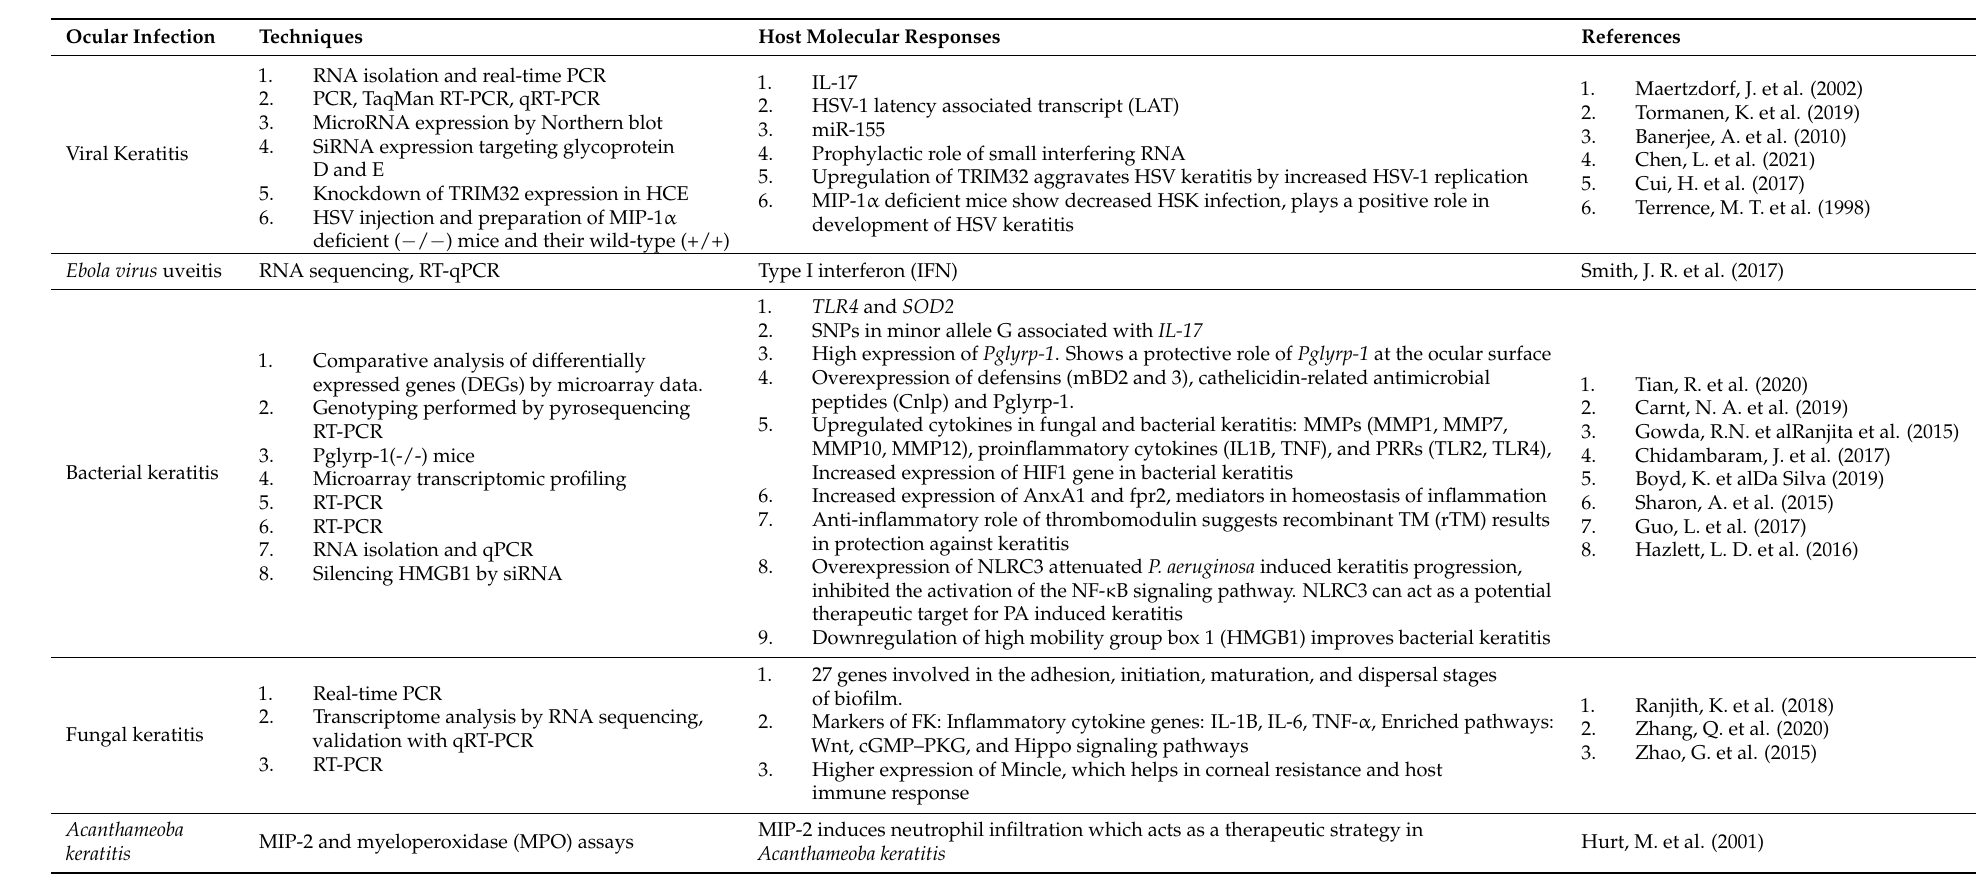
Table 3. Host response genes in ocular microbial